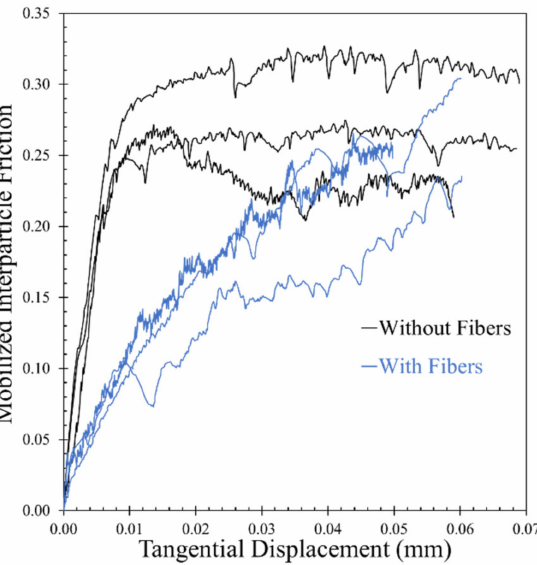
Figure 14. Grain-scale test results: Tangential load—displacement of ( a ) Pure sand particle contacts. ( b ) Sand particle contacts in the presence of fibers.